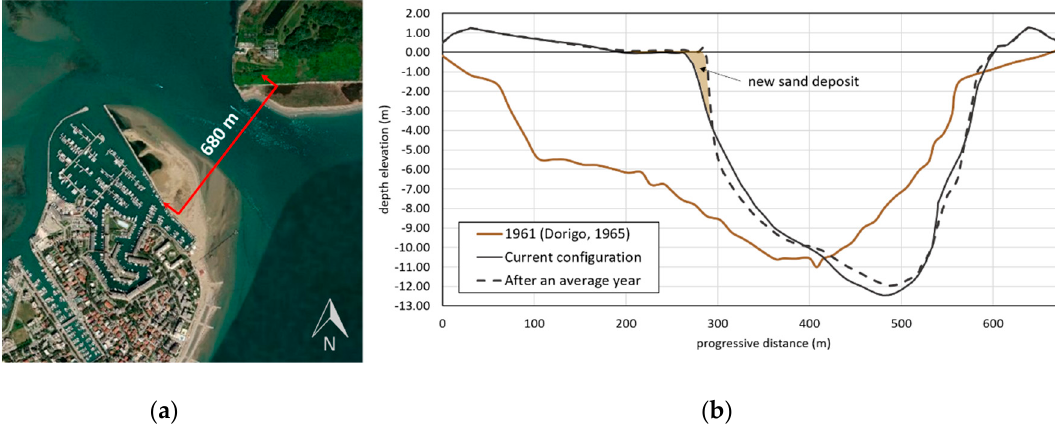
Figure 15. ( a ) Selected section for the comparison between ( b ) the profiles in the current configuration (black continuous line), that are obtained after an average year (black dashed line) and the one available in 1961 from Dorigo [51] (brown continuous line).